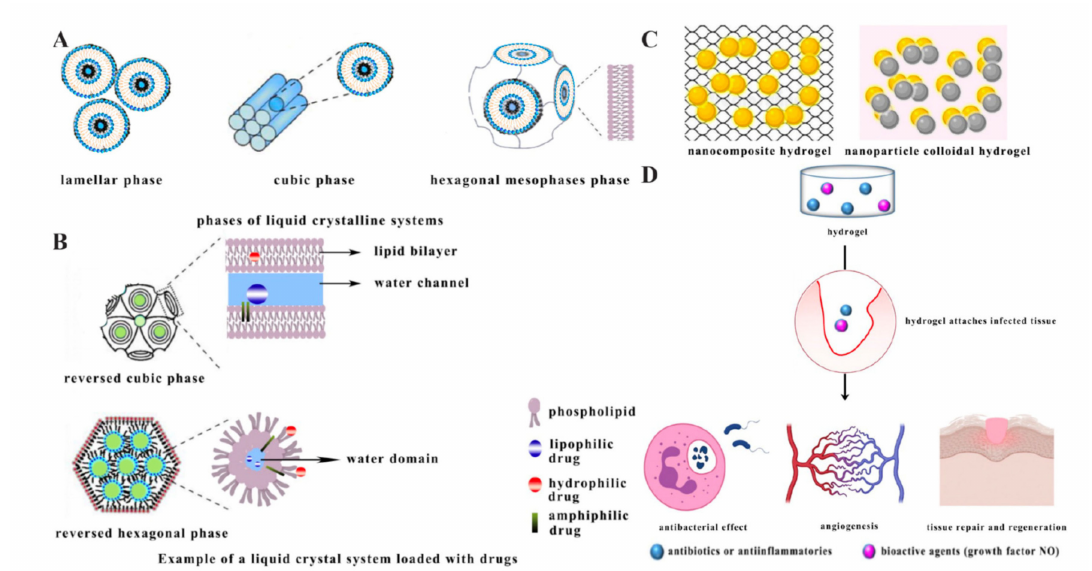
Figure 6. ( A ) Phases of liquid crystal systems adapted from [120]. ( B ) Loading models of Q2 and H2 drug delivery systems adapted from [120]. ( C ) Schematic model of hydrogel adapted from [129]. ( D ) Hydrogel delivers bioactive molecules and is integrative in treating